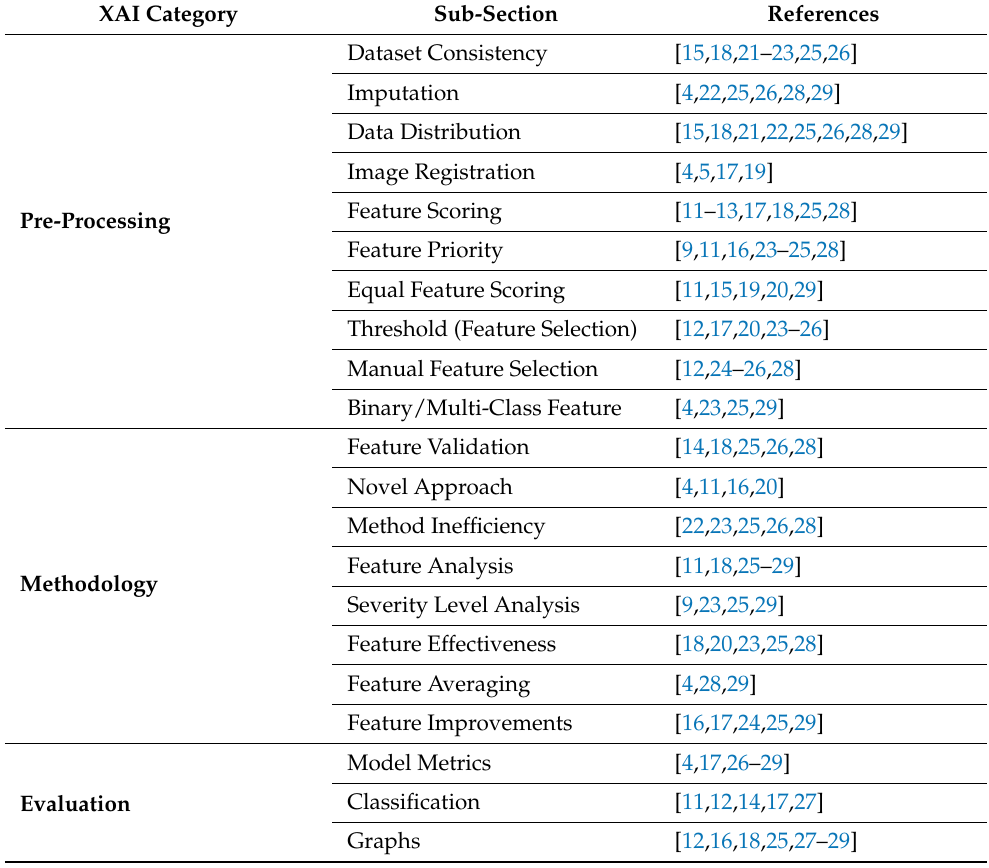
Table 5. XAI Human-In-The-Loop